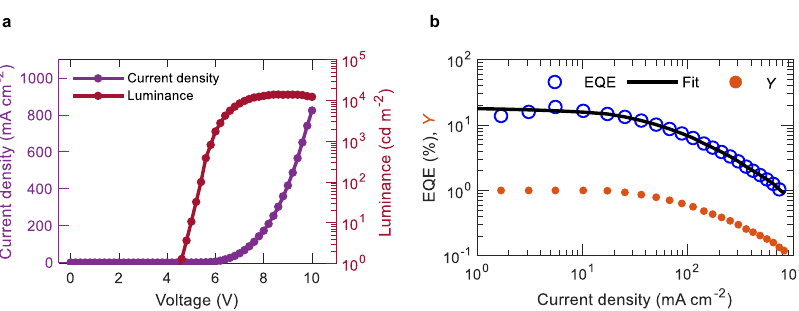
Fig. 3 Device characteristics of mCP:4CzIPN OLEDs. a Current density − voltage − luminance plot. b EQE − current density plot. The solid line represents fi t obtained from Eqs. (3) – (6).